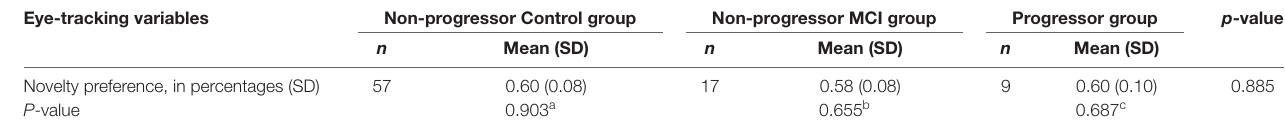
TABLE 4 | Eye movement indices according to the Group (non-Progressor groups: MCI stable and control stable group, Progressor group) using the Kruskal–Wallis test followed by Steel–Dwass multiple comparison tests. Eye-tracking